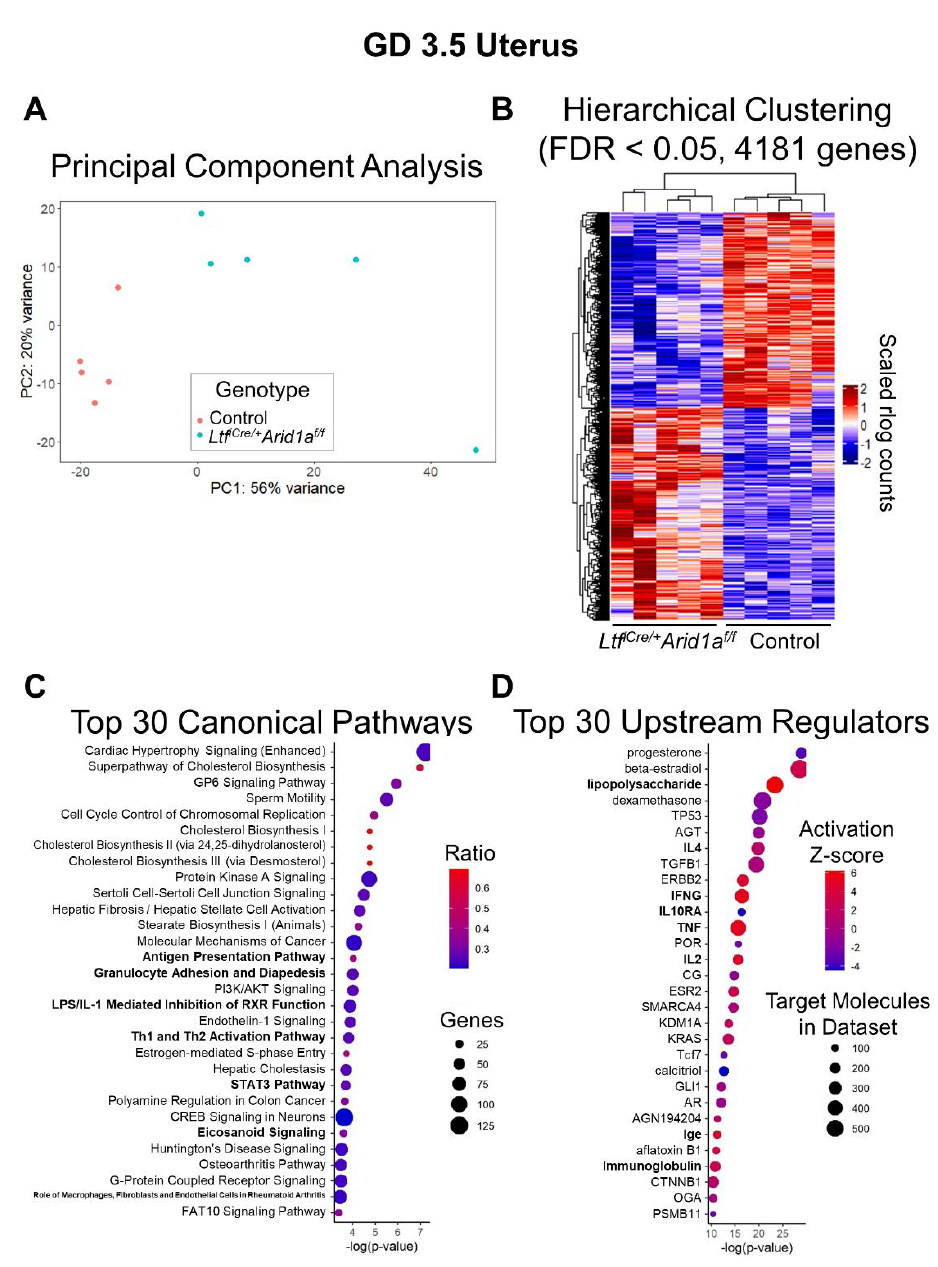
Figure 3. RNA-sequencing analysis of Ltf iCre/+ Arid1a f/f uteri at GD 3.5 reveals large scale transcriptome dysregulation. ( A ) RNA-sequencing was performed on GD 3.5 control and Ltf iCre/+ Arid1a f/f uterine RNA samples ( n = 5/genotype). The PCA plot graphically shows that the overall gene expression patterns are distinct between groups. The plot was created using DESeq2 and ggplot2 in Rstudio. ( B ) Differential expression analysis with DESeq2 identified 4181 (2007 decreased, 2174 increased) significantly differentially expressed genes (DEGs) meeting the threshold of FDR < 0.05, corrected for multiple testing by independent hypothesis weighting. Hierarchical cluster analysis clearly distinguished the two groups based on gene expression patterns. The plot was created using ComplexHeatmap in Rstudio. ( C ) Ingenuity Pathway Analysis of the 4181 genes differentially expressed between control and Ltf iCre/+ Arid1a f/f uteri (FDR < 0.05) identified 194 significantly enriched canonical pathways ( p < 0.05). The plot shows the top 30 pathways from this list based on their corresponding p -values and also displays ratios (genes in current set/total genes in pathway) and number of genes from each pathway dysregulated in Ltf iCre/+ Arid1a f/f uteri. ( D ) Ingenuity Pathway Analysis of the 4181 genes differentially expressed between control and Ltf iCre/+ Arid1a f/f uteri (FDR < 0.05) identified 1526 significantly enriched upstream regulators ( p < 0.05). The plot shows the top 30 upstream regulators from this list based on their corresponding p-values and also displays activation z-score and number